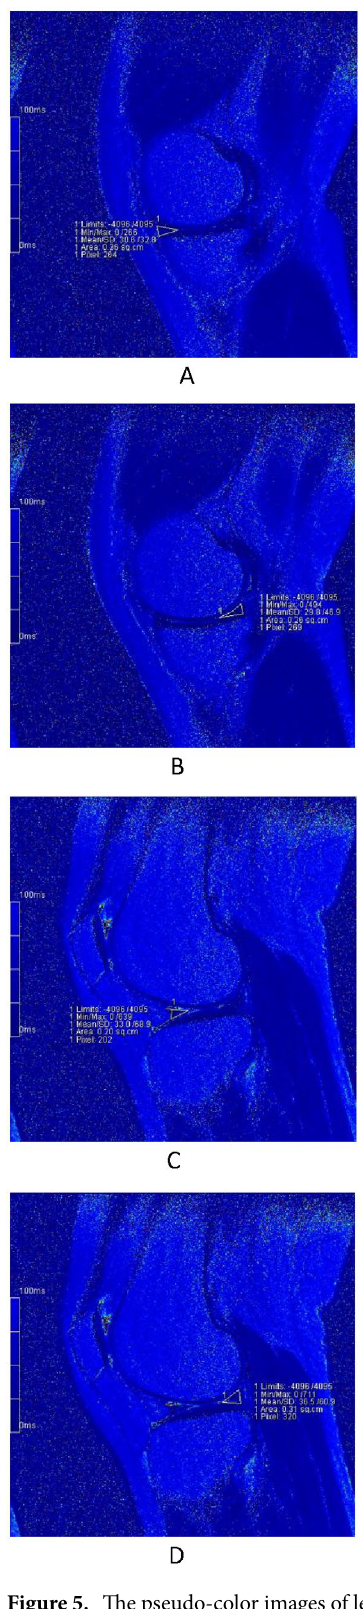
Figure 5. The pseudo-color images of left knee of a 28-year-old female at three timings. ( A )–( D ) are the images 2 months after the match. Fig. A/B/C/D are the images MMAH/MMPH/LMAH/LMPH respectively. The T2 values accordingly were 30.6 ms, 29.8 ms, 33.0 ms, 36.5 ms,